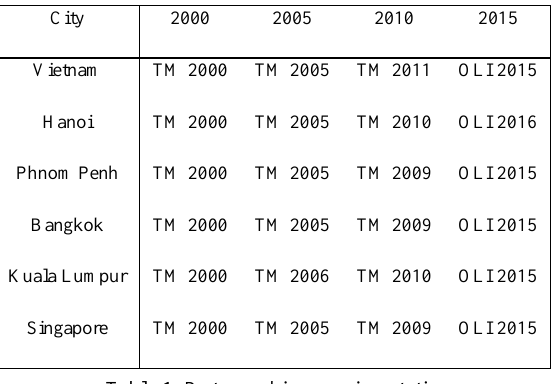
Table 1. Data used in experimentation